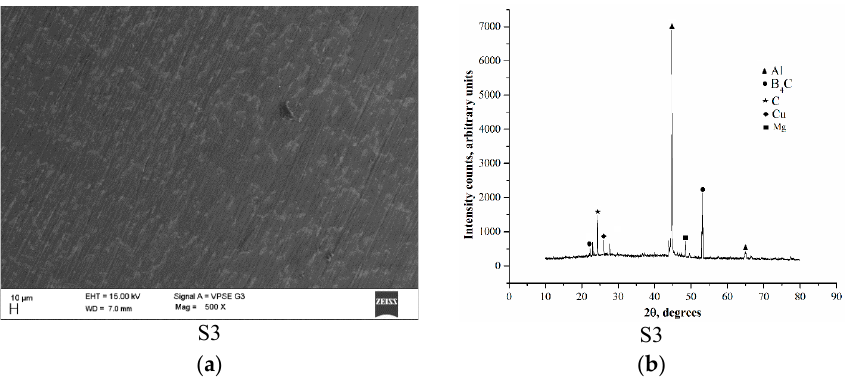
Figure 2. ( a ) SEM of Al2219, and aluminium metal matrix composites (AMMCs); ( b ) XRD of Al2219 and AMMCs.